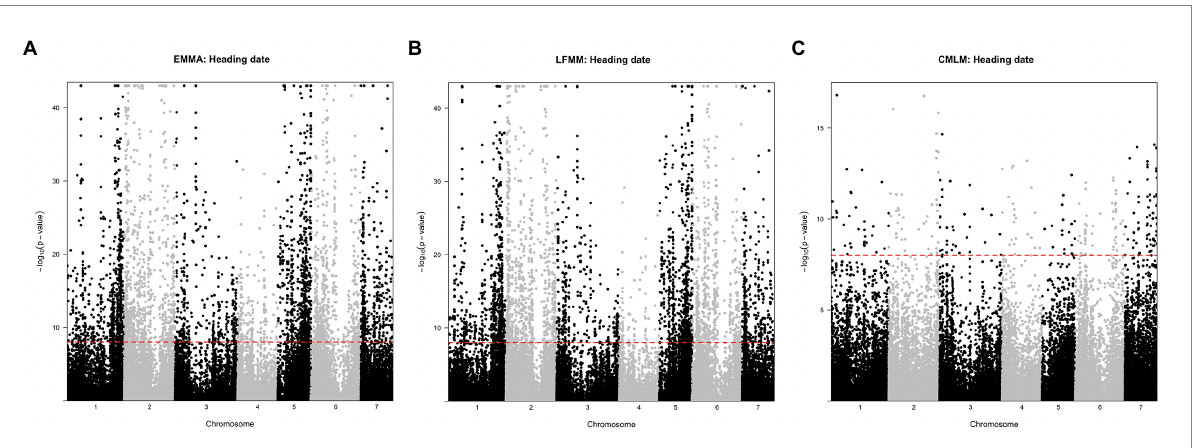
FIGURE 5 Manhattan plots of Fischer combined p -values for association with heading date. (A) with the EMMA approach, (B) with the LFMM approach, and (C) with the CMLM approach. Black and grey colors indicate chromosome. The red dashed line represents the 10 − 8 value considered for significance. Manhattan plots for the remaining traits are in the Supplementary Figure